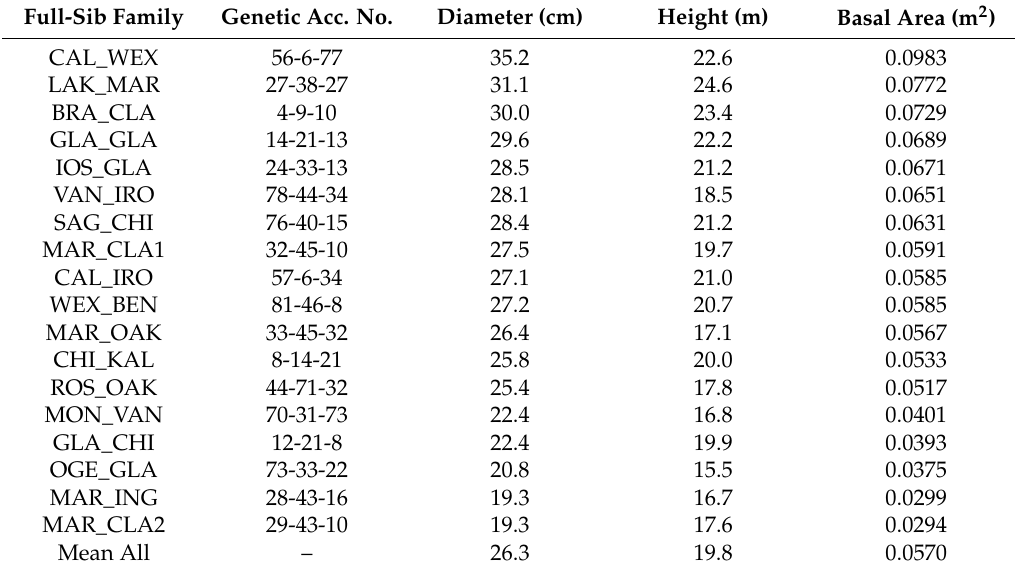
Table 1. Growth characteristics of the 18 full-sib families of hybrid aspen. The hybrid aspen families are sorted from the family with the highest diameter and basal area (CAL_WEX) to the family with the smallest values (MAR-CLA2).